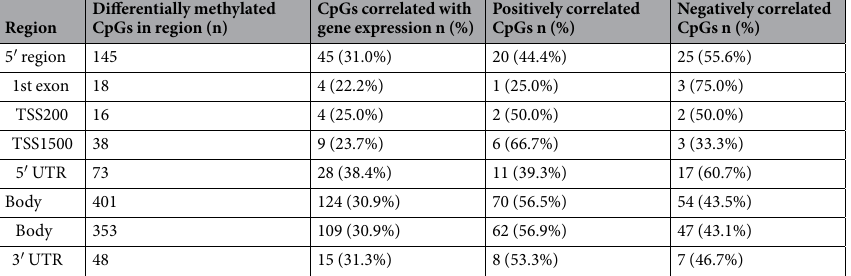
Table 4). This is largely mirrored by region-level analyses of DMRs, involving 1,206 genes associated with increased methylation and 275 with decreased methylation in receptive phase, respectively, which show that pro- cesses related to extracellular matrix and cellular adhesion are most affected by differential methylation (Fig. 5b, Supplementary Table 5). To functionally annotate the genes showing correlation between site-level methylation and gene expression (72 negative and 85 positive correlations), we used gene ontology analysis, which showed that positively correlated genes are related to extracellular matrix organization ( ITGAE , LAMA4 , NID1 , TGFB3 , COL4A2 , ADAMTS1 , VCAM1 , and COL6A2 ) and immune response ( FYN , BCL3 , PVR , JAK3 , IL1RL1 , RFTN1 , MYO1G , CXCL13 , and C1S ), while no enrichment in biological terms was seen for negative correlations (Fig. 5c, Supplementary Table 6).